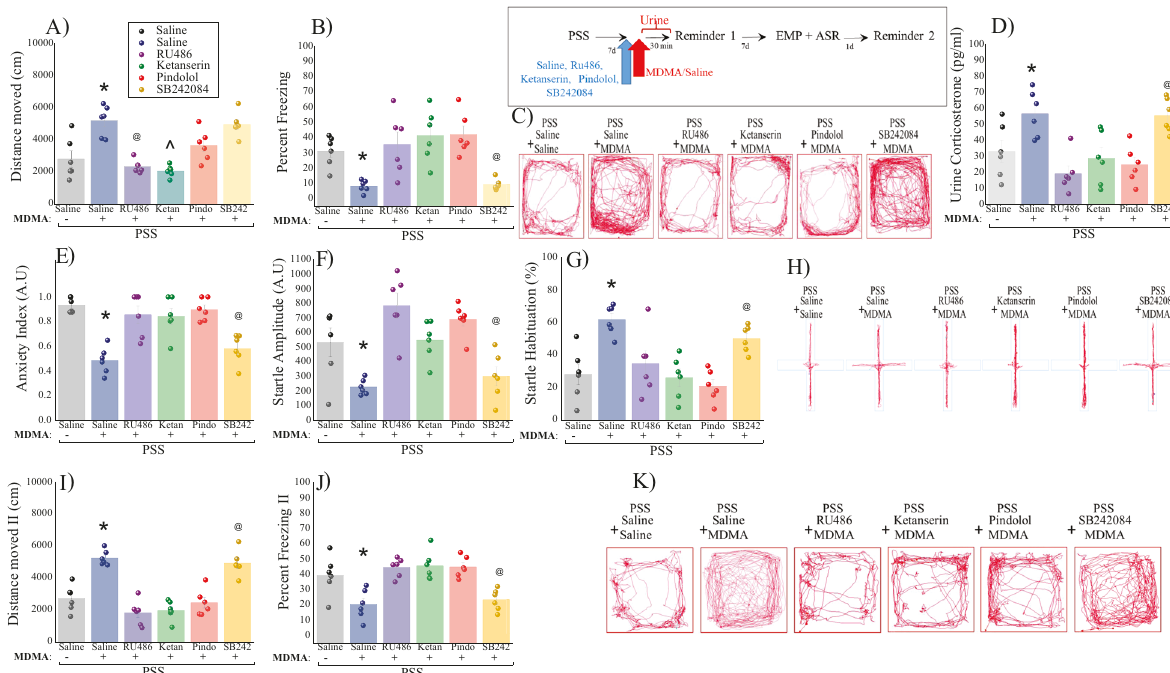
Fig. 5 The glucocorticoid receptor and the serotonin receptors 5-HT- 1A and 5-HT- 2A are necessary for the anxiolytic effects of MDMA: (1) Top panel: experimental protocol. Rats were exposed for 10 min to predator-scent stress (PSS) on day 0. On day 7 rats were intraperitoneally injected with either saline, Ru486 (7.5 mg) (GR antagonist mifepristone), Ketanserin (5 mg/kg) (5-HT 2A R antagonist), Pindolol (0.3 mg/kg) (5- HT 1A R antagonist) or SB242084 (0.3 mg/kg) (5-HT 2C R antagonist) and 30 min before MDMA (5 mg/kg|) or saline injection, administered 30 min before a brief memory reactivation session. There were 6 rats per group. During this time A LMA (distance moved; measured in cm); B Percent freezing response; C Representative patterns of locomotor activity (cumulated values) in all groups. D Urine corticosterone concentrations** (pg/ml). Behavioral measurements (EPM and ASR) were performed on day 14 and freezing behavior on day 15. E Anxiety index, which integrates the measured EPM behavioral measures; F Startle amplitude in the ASR paradigm; G Percentage of startle habituation in the ASR paradigm. H Representative accumulated movement track of the rats during a trial. Finally, the effect of trauma-cue at day 15 on LMA I (distance moved; measured in cm); and J Percent freezing response; K Representative patterns of locomotor activity (cumulated values) in all groups. The experiments described below were performed with two different cohorts of animals; 18 rats were run in one experimental design, and 18 rats in another experimental design. Bars represent group means ± SEM and DISCUSSION The main fi ndings of this study demonstrate that MDMA injection 30 min before exposure to a trauma-cue (memory reactivation) 7 days after PSS-exposure has observable long-term effects on stress-induced behavior in a translational PTSD model. Single-dose MDMA (5 mg/kg) resulted in a signi fi cant reduction of anxiety- related behavior and attenuation of PTSD-related responses compared to saline treatment (8 days later). Retrospective data analysis revealed that the MDMA regimen reduced the prevalence rates of PTSD phenotypes (EBR) to nil, with a concomitant increase in MBR (unaffected) prevalence to 44% as compared to saline treatment (MBR = 0%), (i.e., a signi fi cant overall shift towards more adaptive behavioral response patterns to PSS). The MDMA-treated group also demonstrated markedly less extreme freezing responses to re-exposure to the trauma-cue than the saline- control group (27.7 5% vs. 47.5%, respectively). Freezing behavior indicates a sense of immediate threat and intense fear. For a neutral stimulus to cause a freezing response, (i.e., to act as a trauma-cue), it requires the involvement of contextual association with the stressor through memory-related processes. The fi nding that MDMA administration prior to such exposure effectively prevented this effect raises the possibility that it affects memory- related processes. Importantly, MDMA had no long-term intrinsic pharmacother- apeutic ef fi cacy in and of itself and was effective in attenuating behavioral responses only when paired with trauma reactivation by a trauma-cue (i.e., 30 min before) (suggesting that the memory reactivation is necessary), that is, animals who actively “ recalled ”